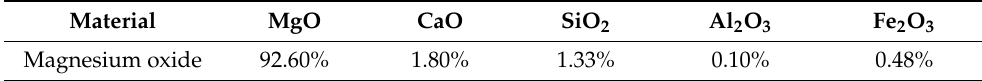
Table 1. Chemical compositions of the caustic burnt magnesium oxide.